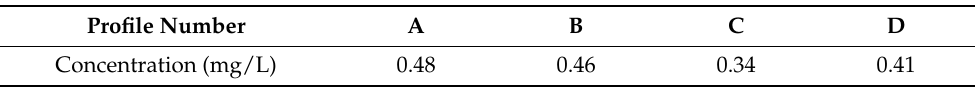
Table 3. Concentrations of ammonia in each profile.